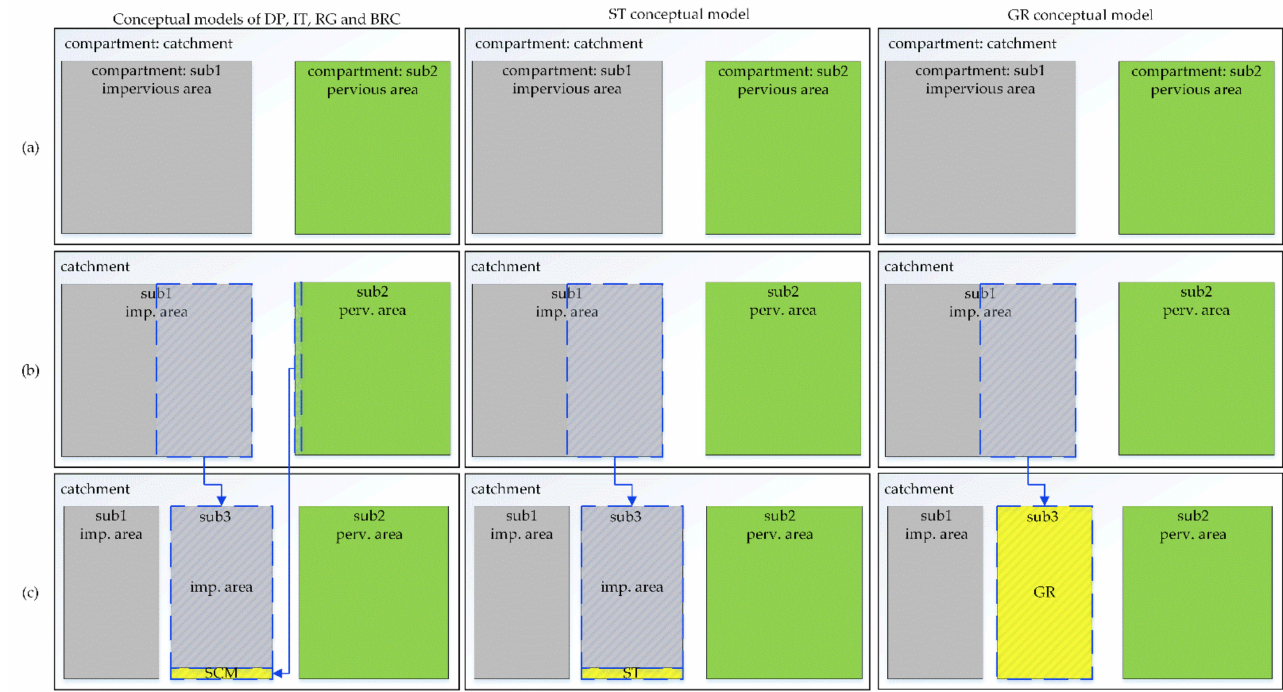
Figure 4. Graphical representation of the development of the conceptual model structure that includes stormwater control measures (SCMs). ( a ) Initial conceptual model with two sub-compartments; ( b ) Introduction of SCM together with contributing area; ( c ) Final conceptual model including SCM consisting of three